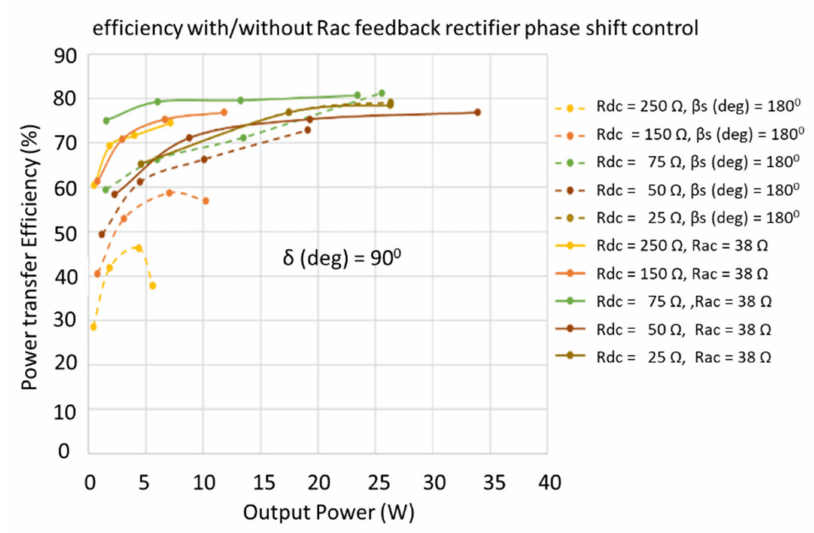
Figure 25. Power efficiency measurement with/without R ac feedback